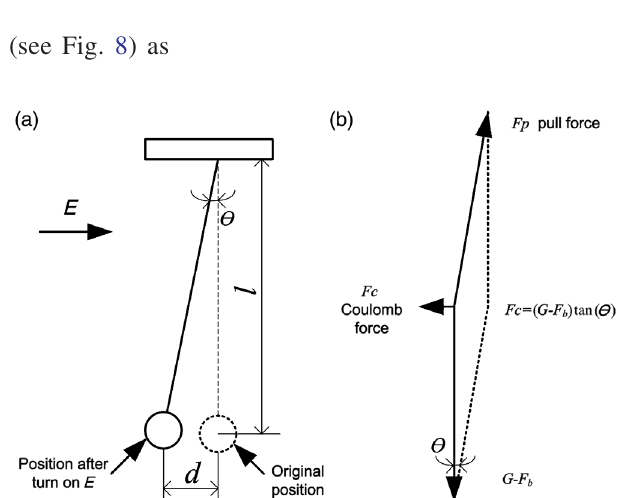
FIG. 9. Charge of spherical beads of different dielectric materials after contact with the